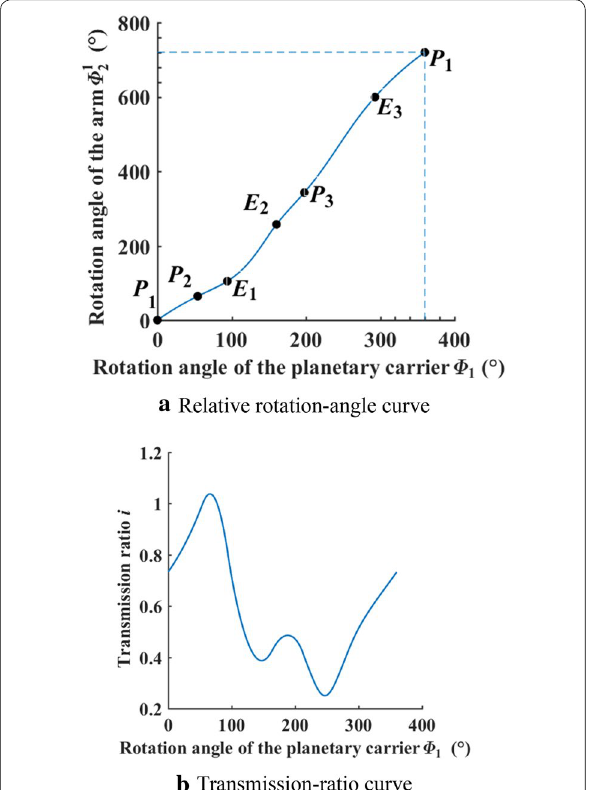
Figure 15 Relative rotation-angle curve and transmission-ratio